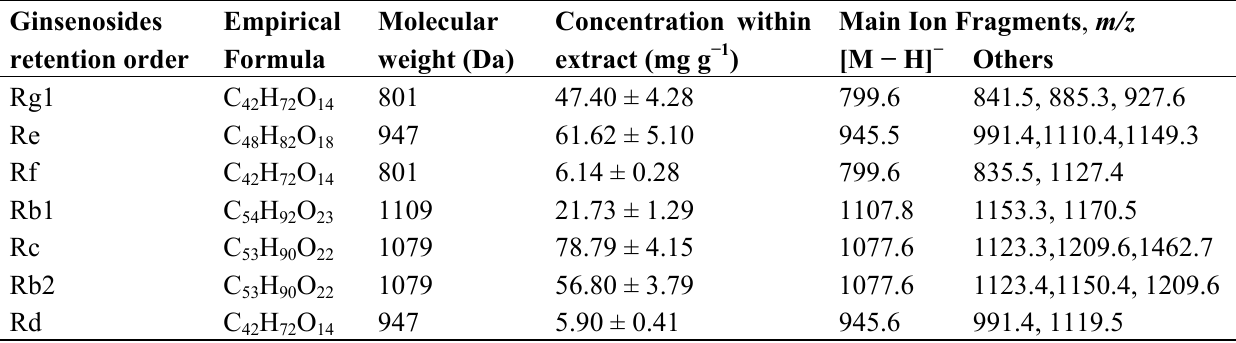
Table 2 . Seven major ginsenosides detected by ESI-MS